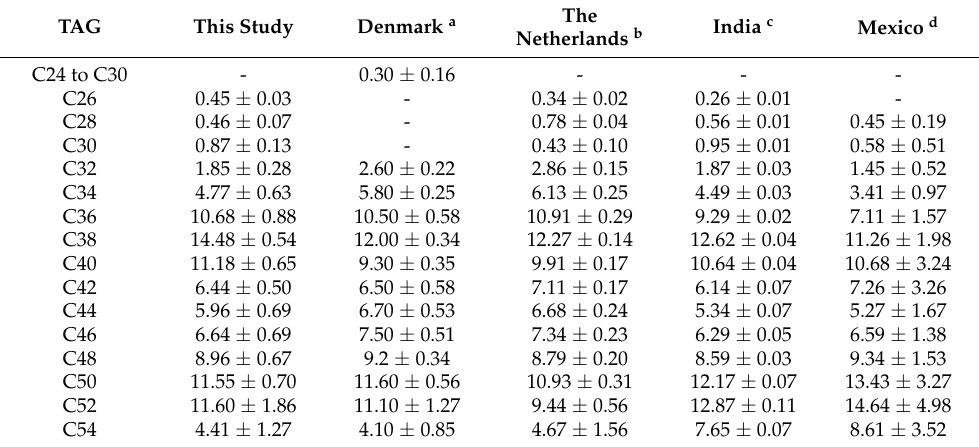
Table 2. Means (% w / w ) and standard deviations of triacylglycerides in organic and conventional bovine milk fat from different